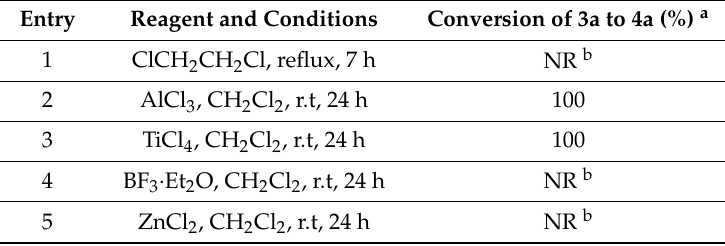
Table 1. Intramolecular heterocyclization of 3a